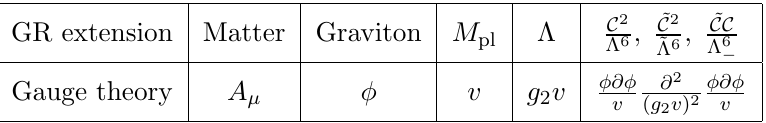
Table 2 . The mapping between the GR extension studied in this paper and the toy gauge theory